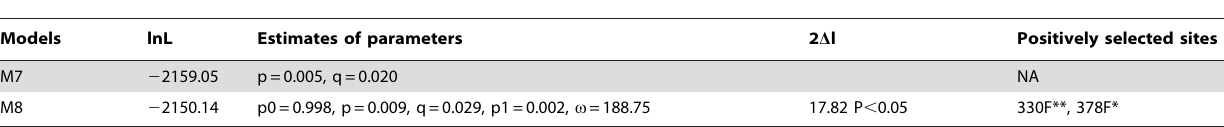
Table 7. Site-specific tests for positive selection on HPV-16 L2.